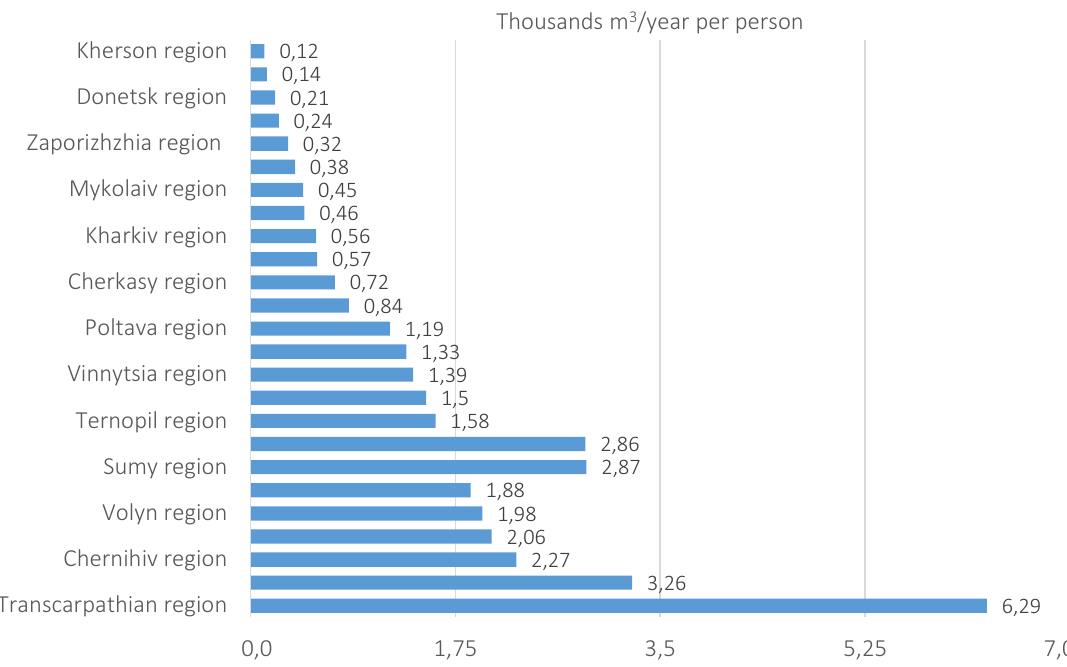
Figure 2. Provision of the population of Ukraine